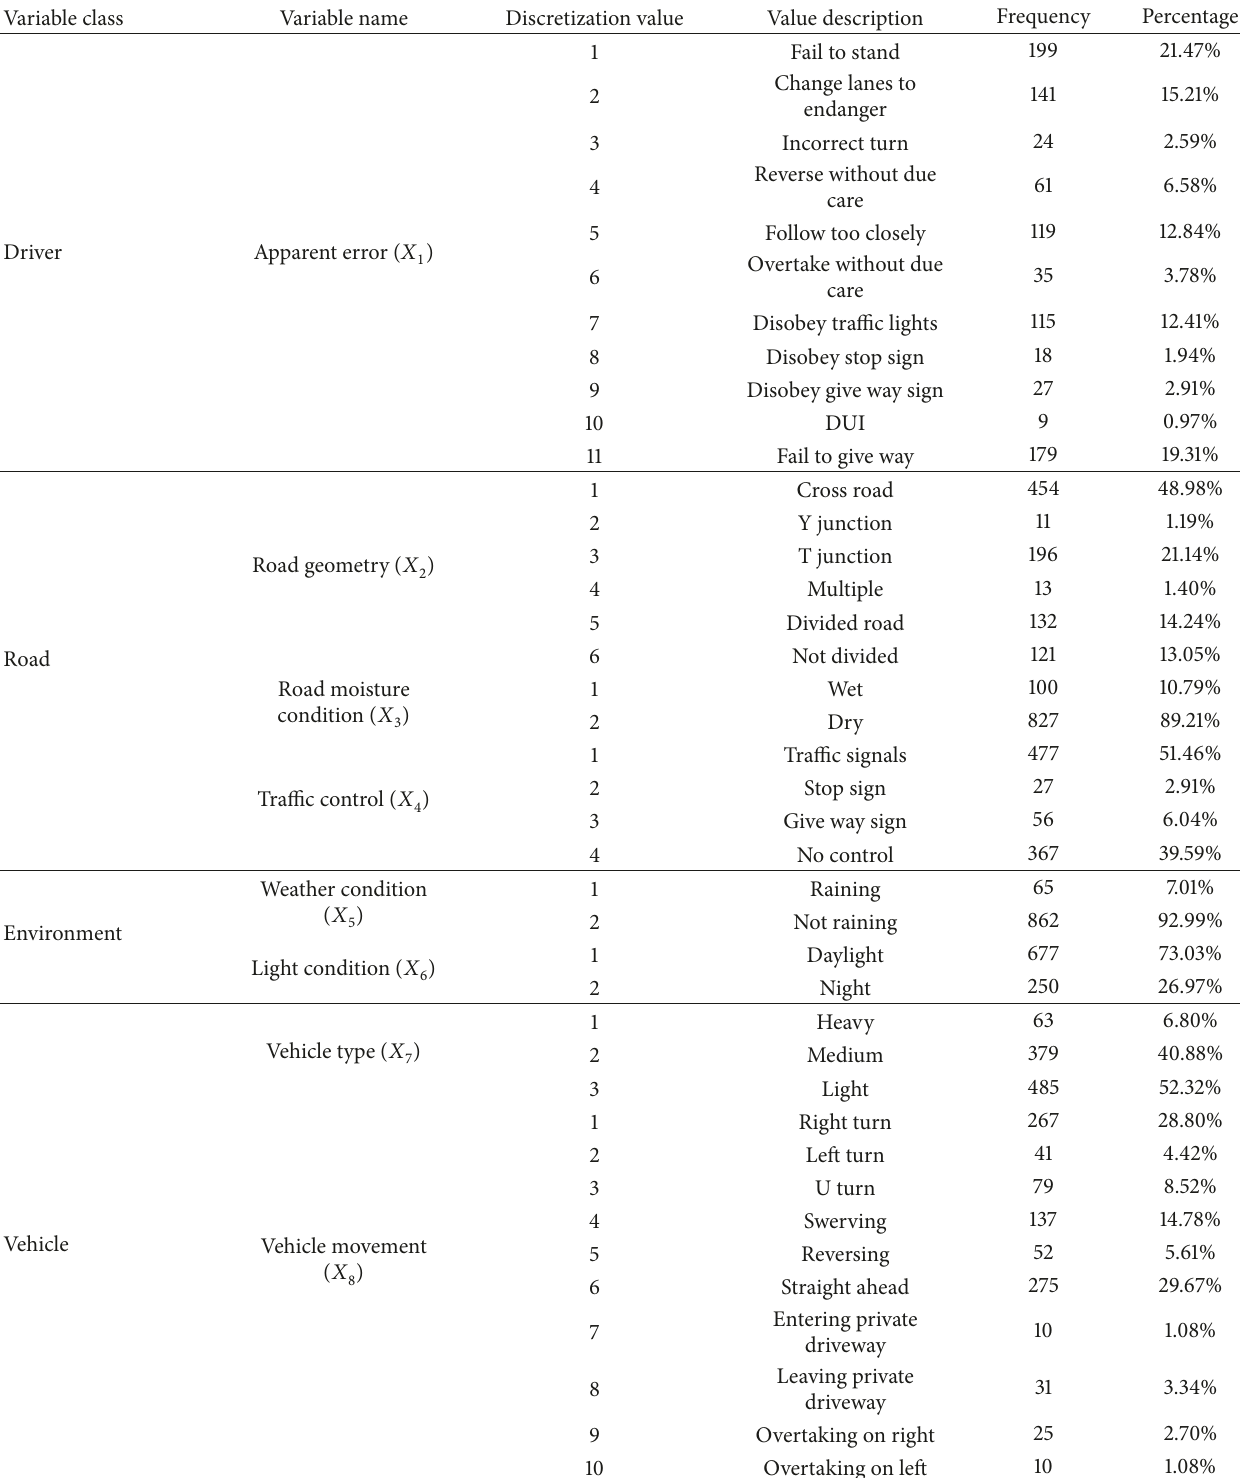
Table 2: Variables used for the Construction of Bayesian